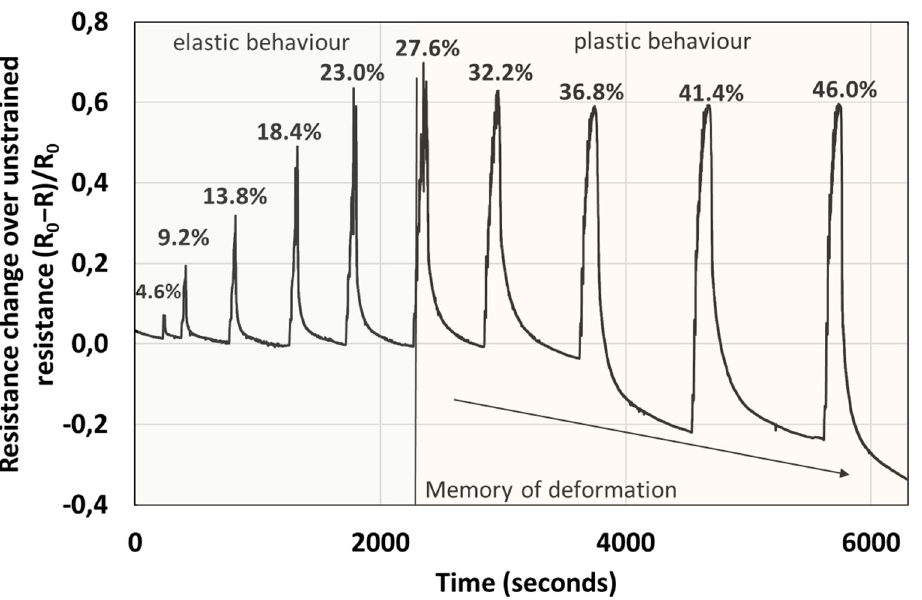
Figure 8. Graph depicting the resistance change over unstrained resistance with compression. There are two different regimes, the elastic regime, where the resistance change is proportional to the applied force, and the plastic regime where the resistance plateaus. The labels of the peaks correspond to compressive strain of the material. In the plastic regime, strain > 27%, the recovery of the resistance in the relaxation stage increases beyond the baseline, proportionally to the force applied in the plastic regime. Note that the applied strain in the relaxation stage is 0%. This observed effect we call the memory of plastic deformation.